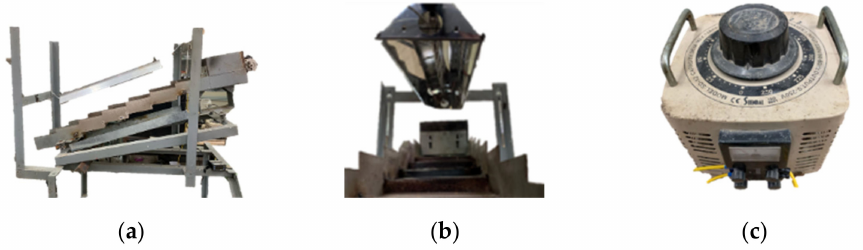
Figure 3. Infrared radiation unit ( a ), near-infrared radiation generator with tungsten ( b ), and voltage controller ( c